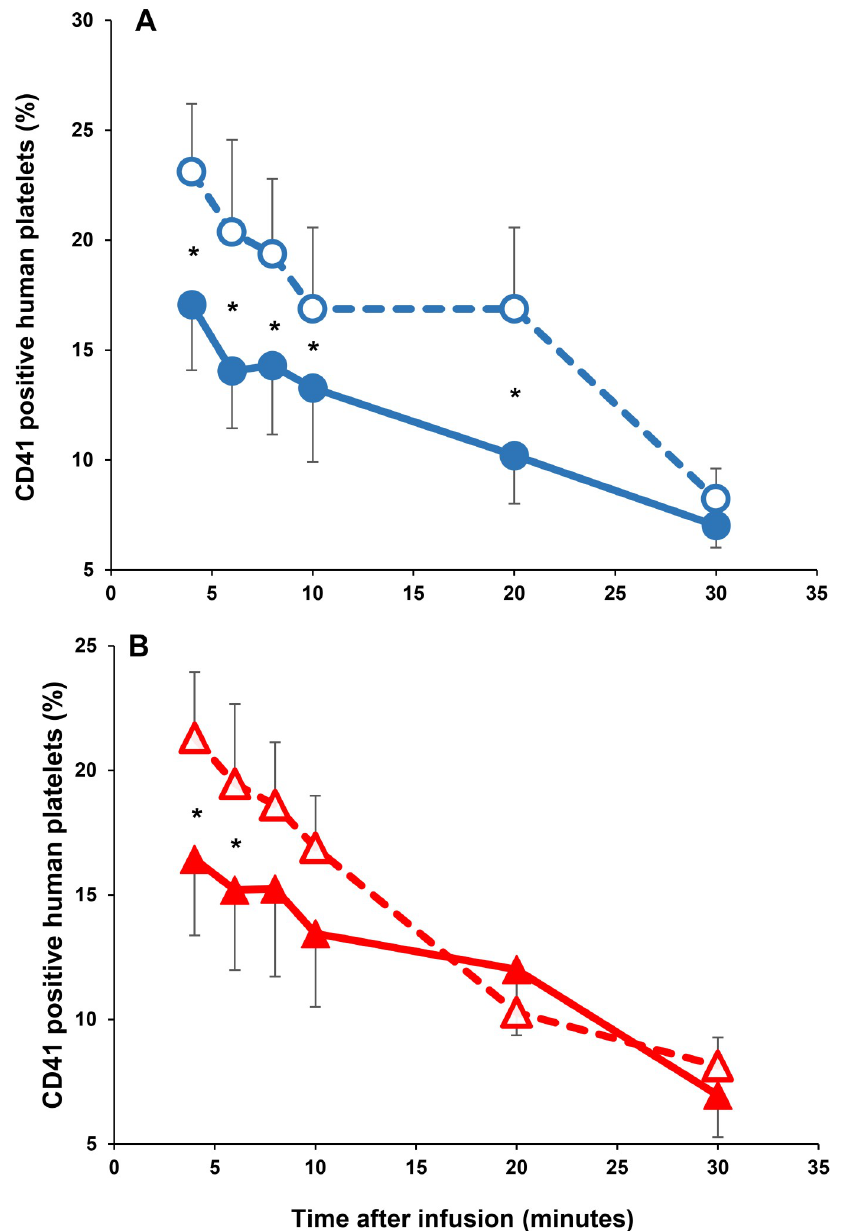
Fig 12. Recovery of human platelets stored for 14 days at cold and thermocycled temperatures. Panel A depicts the recoveries of human platelets stored at cold temperature. Open circles and dashed line represent the recoveries of cold- stored + VX-702 human platelets in SCID mice. Close circles and solid line illustrate the recoveries of cold-stored human platelets in SCID mice; � 4 min p = 0.0001; 6 min p = 0.0126; 8 min p = 0.0127; 10 min p = 0.0053; 20 min p = 0.0177; 30 min p = 0.1402. Panel B provides the recoveries of human platelets stored at thermocycled temperature. Opened triangles and dashed line represent the recoveries of thermocycled-stored + VX-702 human platelets in SCID mice. Closed triangles and solid line reproduce the recoveries of thermocycled-stored human platelets in SCID mice; � 4 min p = 0.0412; 6 min p = 0.01353; 8 min p = 0.1059.